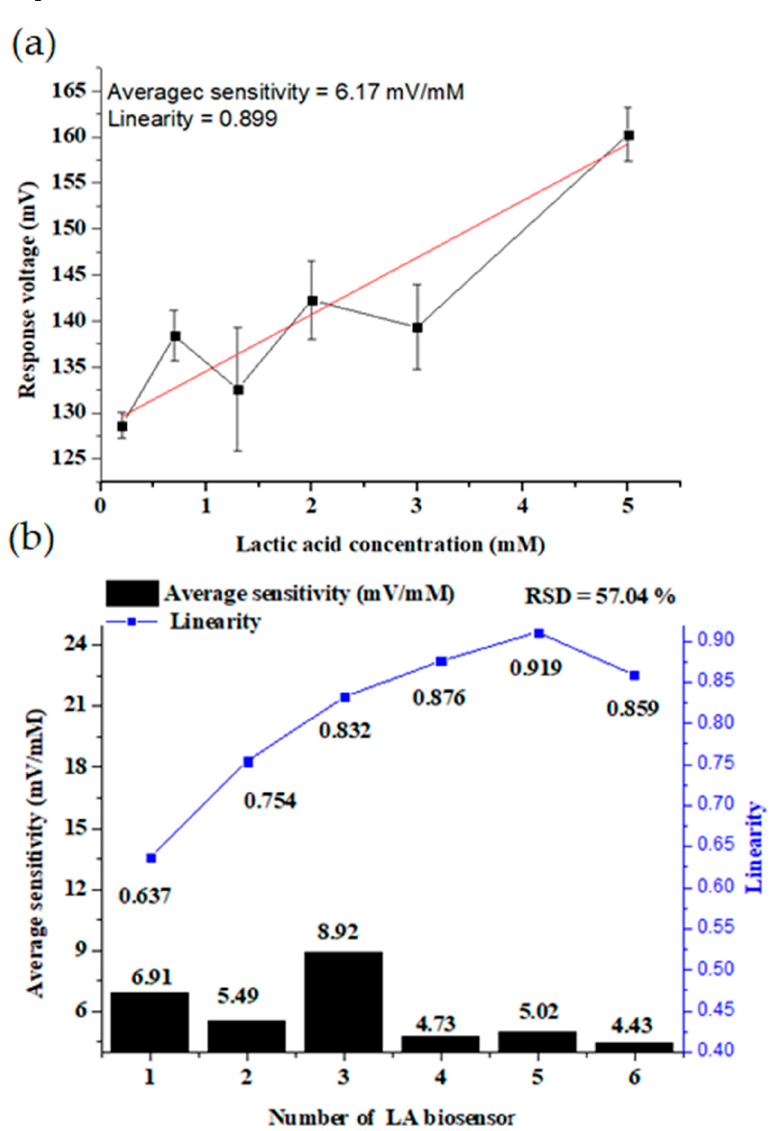
Figure 12. The ( a ) average sensitivity and linearity; ( b ) reproducibility of the standard sensor.